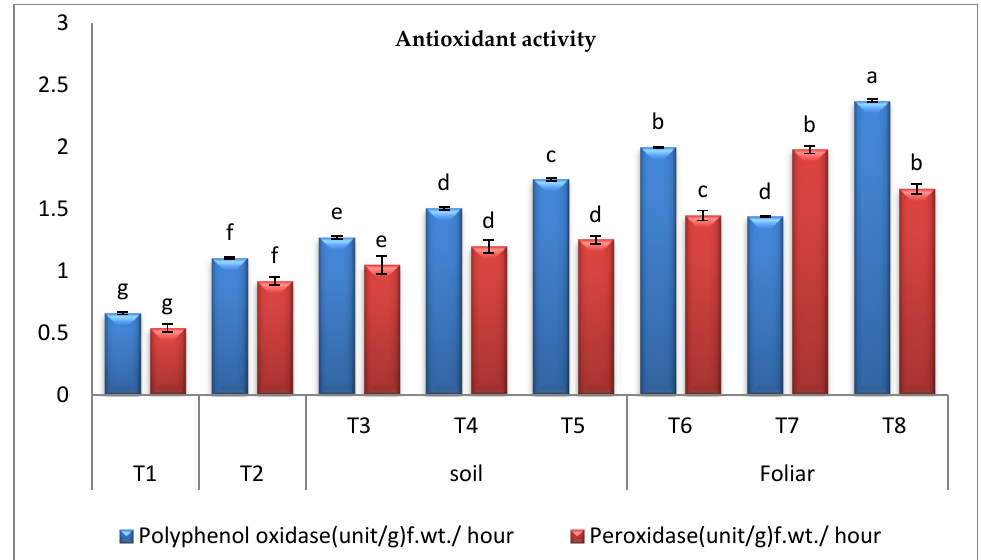
Figure 5. Effect of cyanobacteria on the activity of oxidative enzymes in the infected pepper plants (T1-healthy control, T2-infected control, T3-infected plants treated with D. muscorum soil, T4-infected plants treated with A. oryzae soil, T5-infected plants treated with A. platensis soil, T6-infected plants treated with D. muscorum foliar spray, T7-infected plants treated with A. oryzae foliar spray and T8-infected plants treated with A. platensis foliar application.) (Data represent mean ± SD, n = 3), (a–g Letters revered to significant in statically analysis).